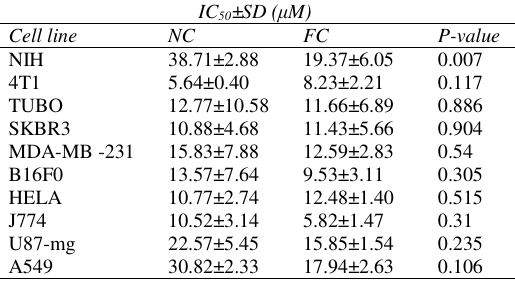
TABLE 2: Normal and cancer cells Half maximal inhibitory concentration (IC50) of free and nanomicelle form of curcuminoids after the 48-hour Table 2. Normal and cancer cells Half maximal inhibitory concentration (IC50; μM) of free and nanomicelle form of curcuminoids incubation period. after the 48-hour incubation